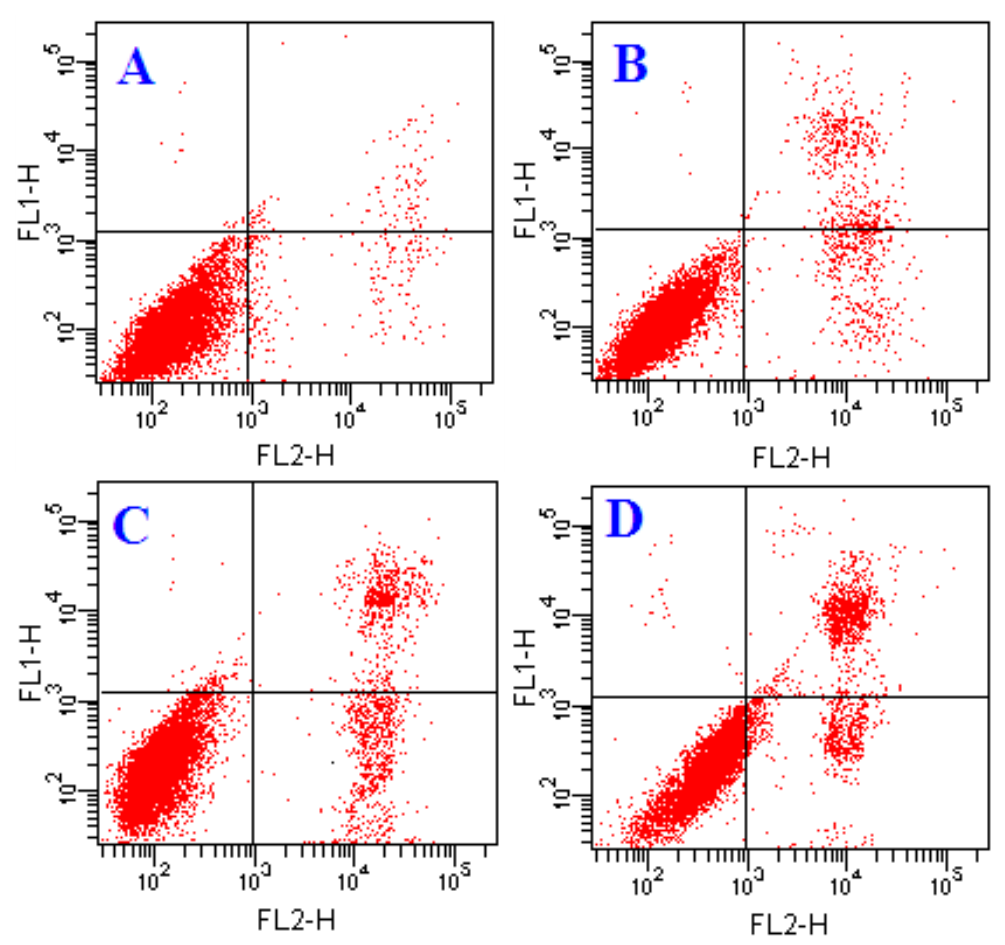
Figure 3. Determination of apoptosis in A549 cells by flow cytometry. Cells were treated with ATL-I at concentrations of 10, 20, and 40 μ M for 48 hours, then cells were stained by Annexin V-FITC/PI and observed by flow cytometry. A – D represent the control, 10 μ M, 20 μ M, and 40 μ M,